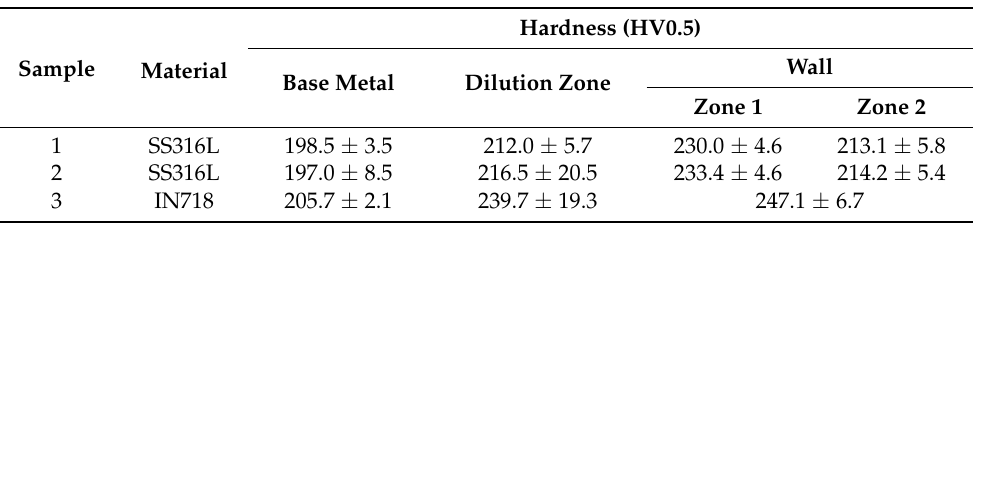
Table 5. Average hardness values and deviation